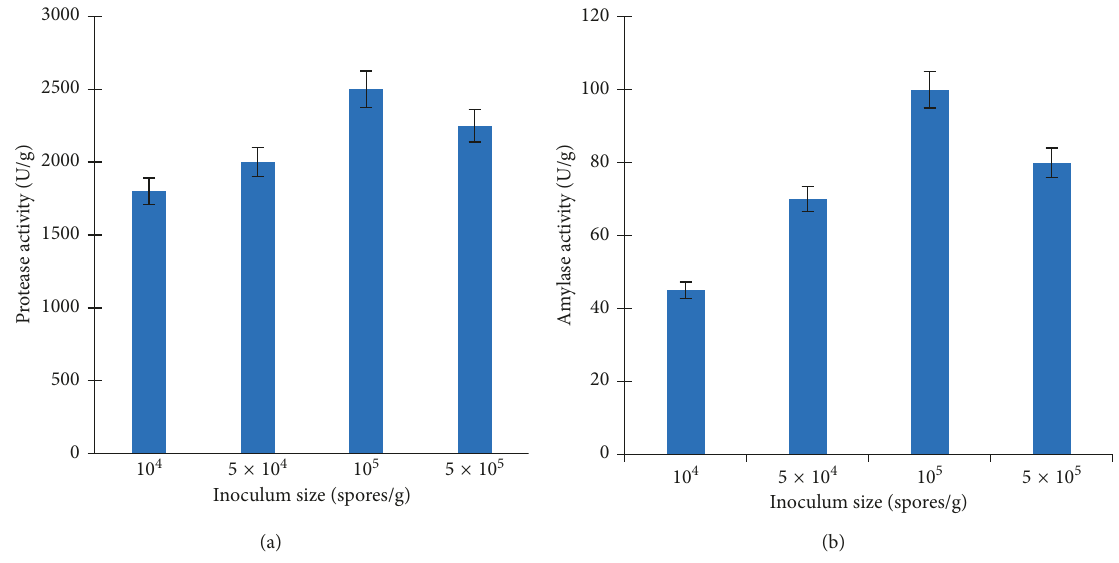
Figure 3: Effect of the initial moisture content (%) on the production of protease (a) and α -amylase (b) by R. oryzae CH under static